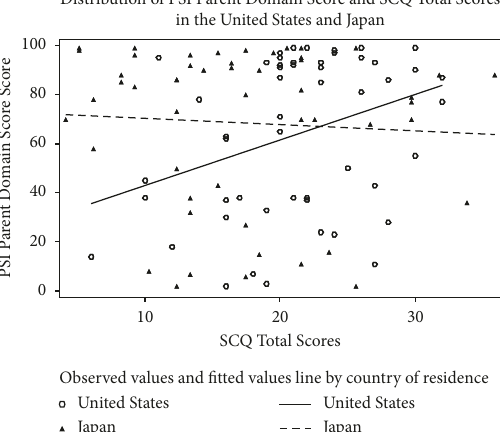
Figure 3: Distribution of the parenting stress index (total, child, and parent domains) and the social communication questionnaire score by country of residence (U.S. and